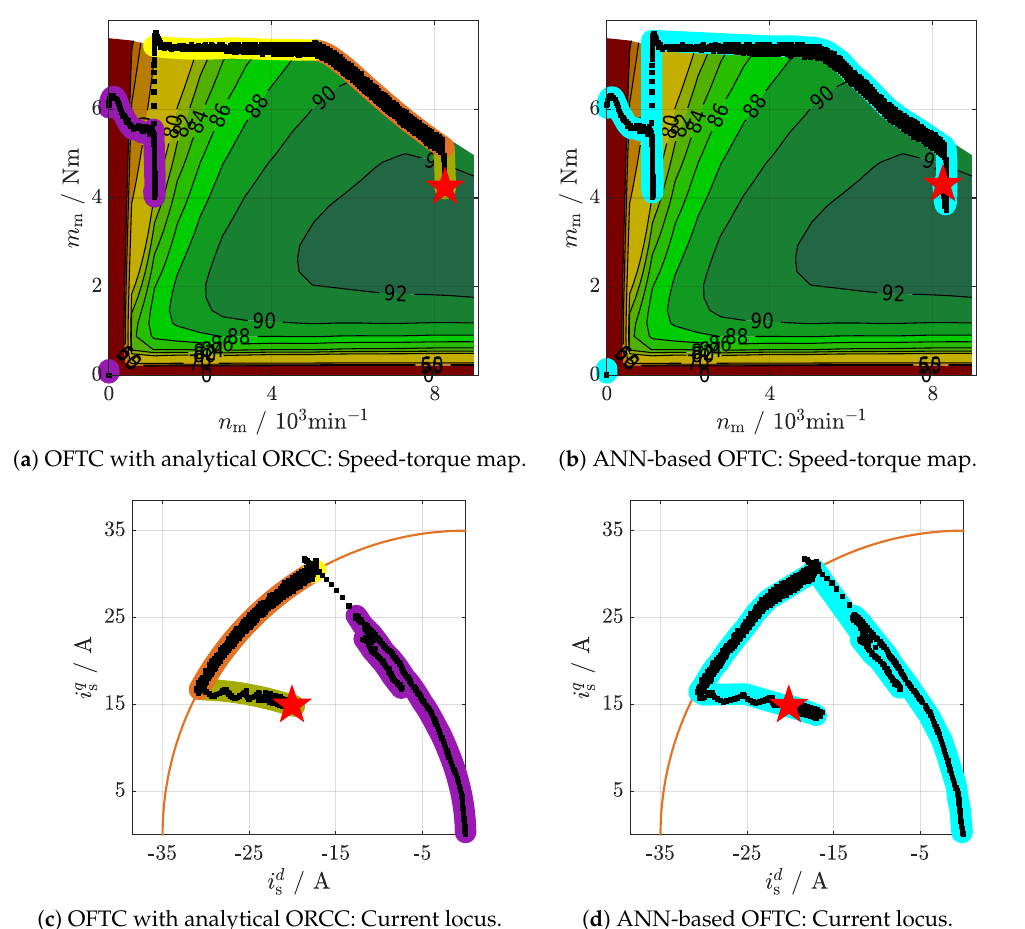
Figure 20. Implementation results: Illustration of optimal operation management considering copper and iron losses minimization and voltage and current constraints—Left column: OFTC with analytical ORCC (OFTC ANA ) with ( a ) speed-torque map and ( c ) current locus; Right column: ANN-based OFTC OFTC ANN with ( b ) speed-torque map and ( d ) current